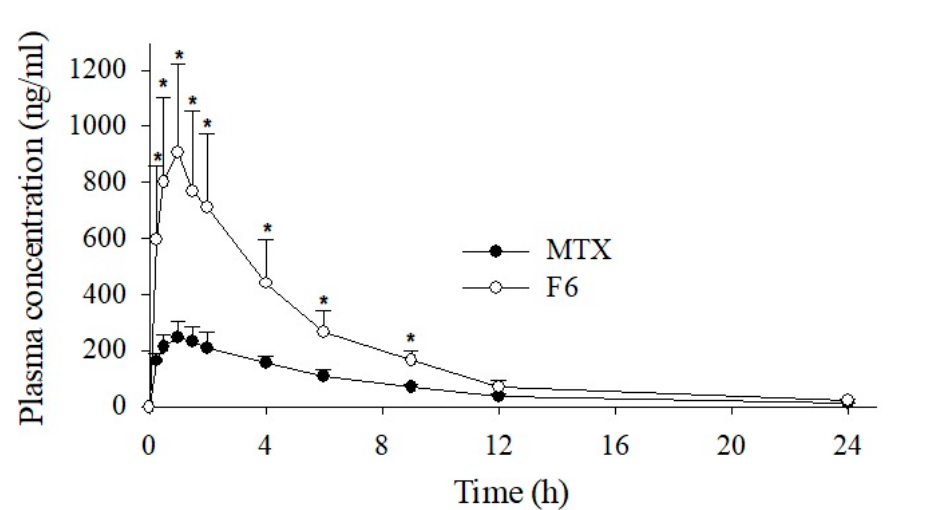
Figure 5. Plasma concentration–time profiles of MTX after the oral administration of the free drug or F6 formulation in rats. Each value represents the mean ± S.D. ( n = 6). * p < 0.05 compared to free MTX. Table 3. Pharmacokinetic parameters of MTX powder, and MTX-loaded SASD formulation (F6). Formulations